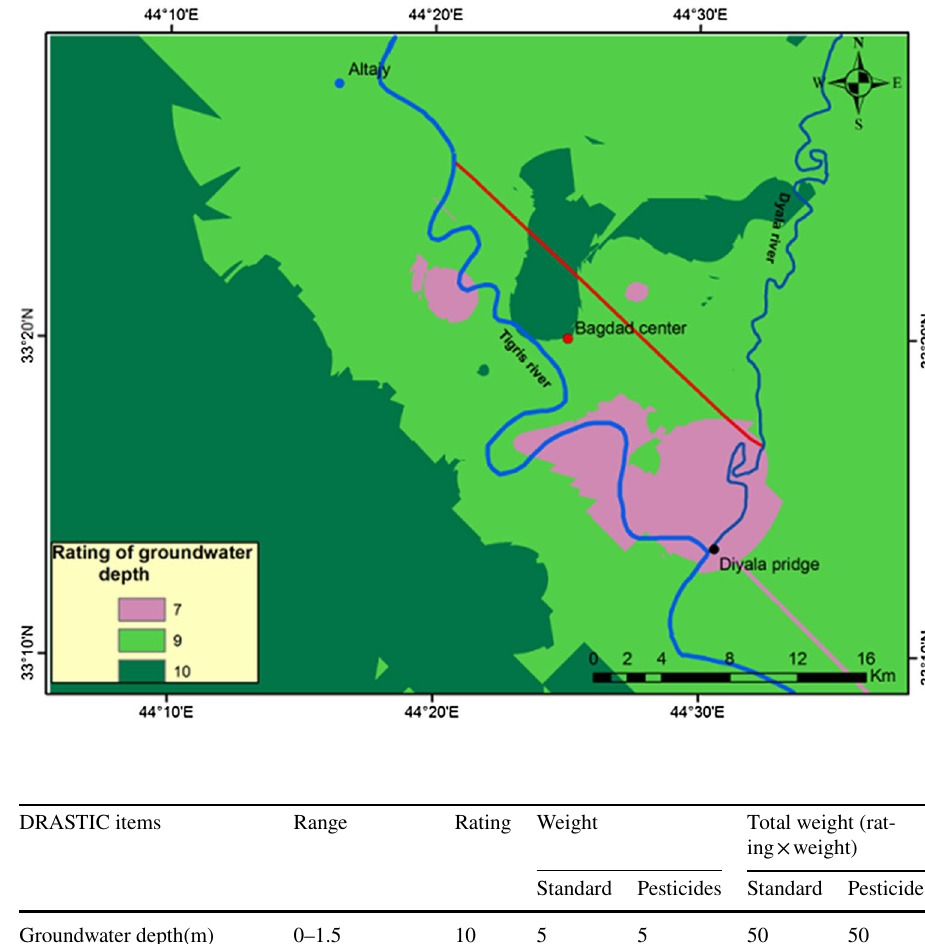
Fig. 5 Rating of groundwater depth map of the study area